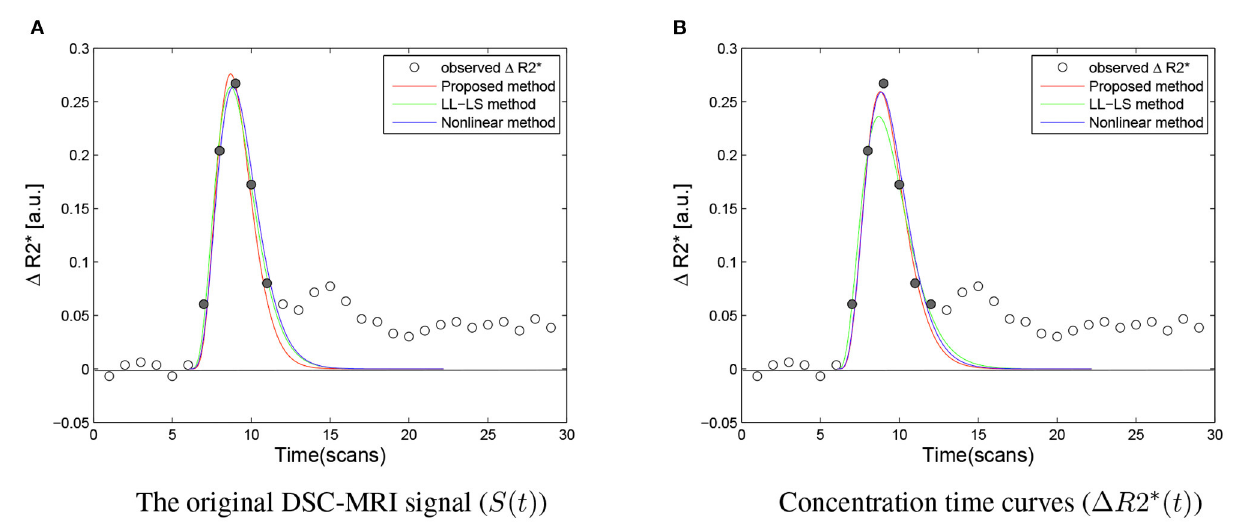
t 0 was excluded from the fitting, the three methods produced very similar results, illustrating FIGURE 6 | (A) Compared with Figure 3 , when the first point near to t = that this point have greater computational weight than other point in the LL-LS method ( α mle 6.9087, β mle 1.3795, F mle 2.4313, α ls 5.5731, β ls 1.7838, = = = = = F ls t 0 , including the additional last point hardly influenced 2.5687, α non 6.0294, β non 1.7116, F non 2.5780). (B) In comparison with the first point near to t = = = = = the results. The nonlinear method and the proposed method showed relatively stable performances for the choice of data points due to all observations being treated in an equal manner ( α mle 5.8765, β mle 1.7348, F mle 2.6190, α ls 4.4527, β ls 2.3626, F ls 2.6610, α non 5.6077, β non 1.8767, F non 2.6624). The = = = = = = = = = 1 R 2 ∗ signal obtained during the first bolus pass is shown as filled circles, while the other sample points are indicated by hollow circles. The area under the fitted 1 R 2 ∗ curve corresponds to the estimated